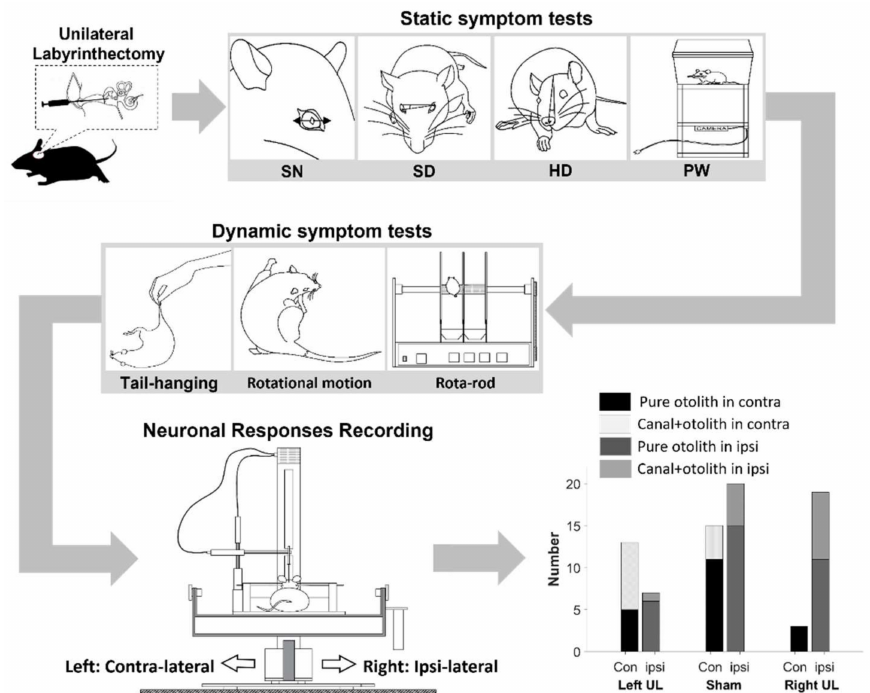
Figure 1. Schematic overview of experimental procedure. The directional preference was determined by the neuronal response to kinetic stim- ulation following the x-axis (passive inter-aural translation), which originated from the utricle. During the repeated right- or leftward linear translation, instantaneous firing rates (IFRs) of the neuron were examined, which were computed by the reciprocal number of inter-spike intervals (ISI). If IFRs increased as the head was linearly translated to the right direction, the neuron was identified as an ipsi-preferred unit. The contra-preferred neurons increased their IFRs as the heads were linearly translated to the left direction. In addition, the neuronal information responding to the horizontal rotation was examined to demon- strate whether the recording response originated from a pure or a convergent neuron.